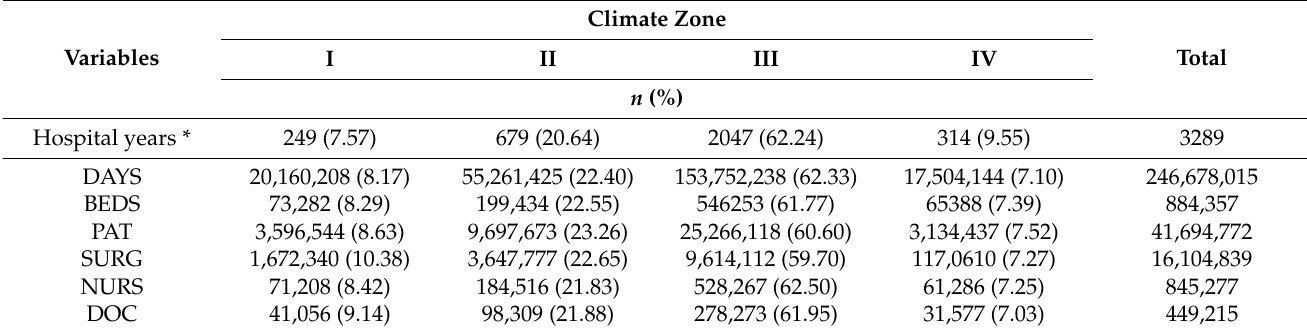
Table 2. The characteristics of analyzed hospitals according to the climate zone in Poland.